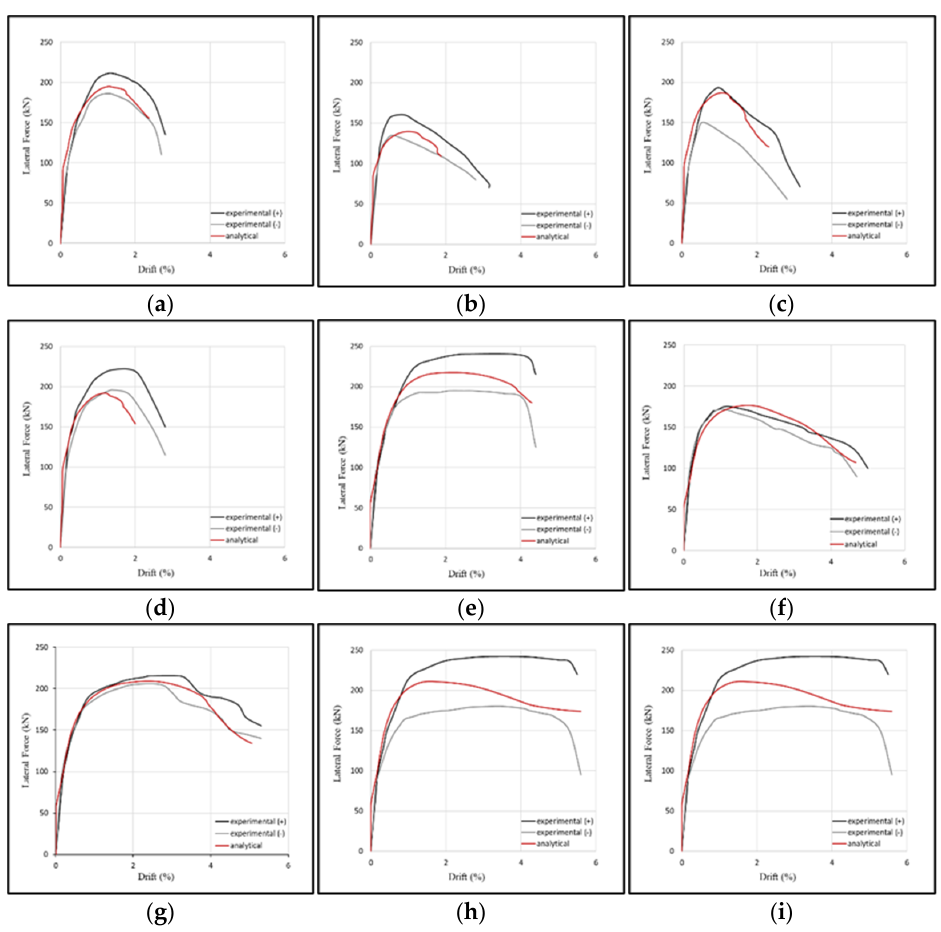
Figure 3. Lateral Force-Drift curves for columns ( a ) R-0L0, ( b ) R-0L1, ( c ) R-0L3, ( d ) R-0L4, ( e ) R-P2L0,